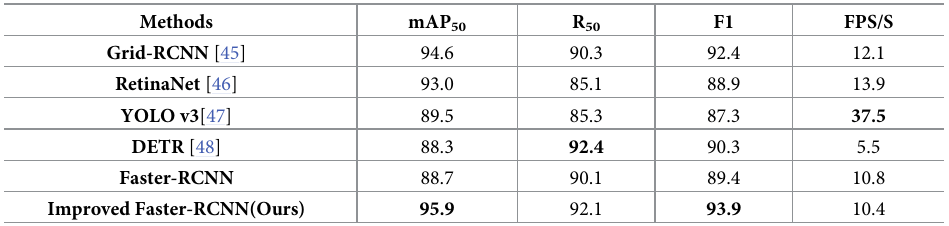
Table 6. Result of different methods on the SDTs